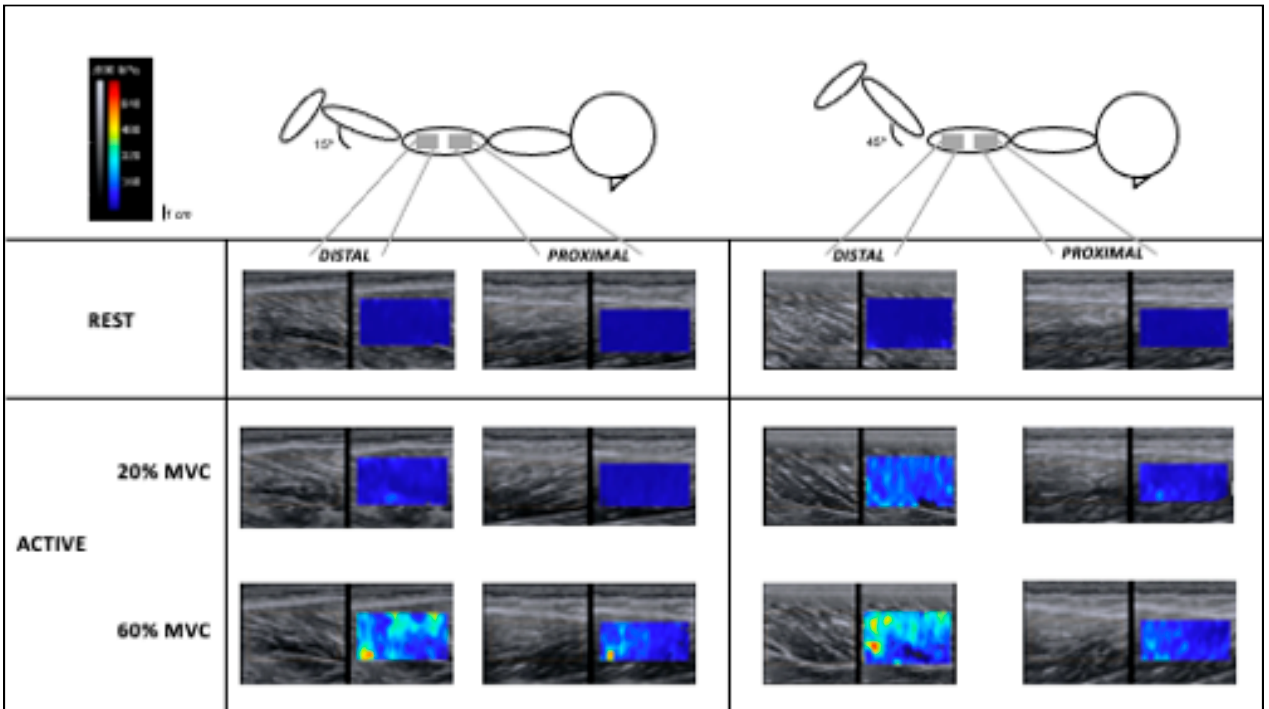
Figure 2. Illustration of one participant’s elastograms under all conditions. To the best of our knowledge, this is the first study to investigate human skeletal muscle stiffness in different muscle regions during submaximal isometric contractions.